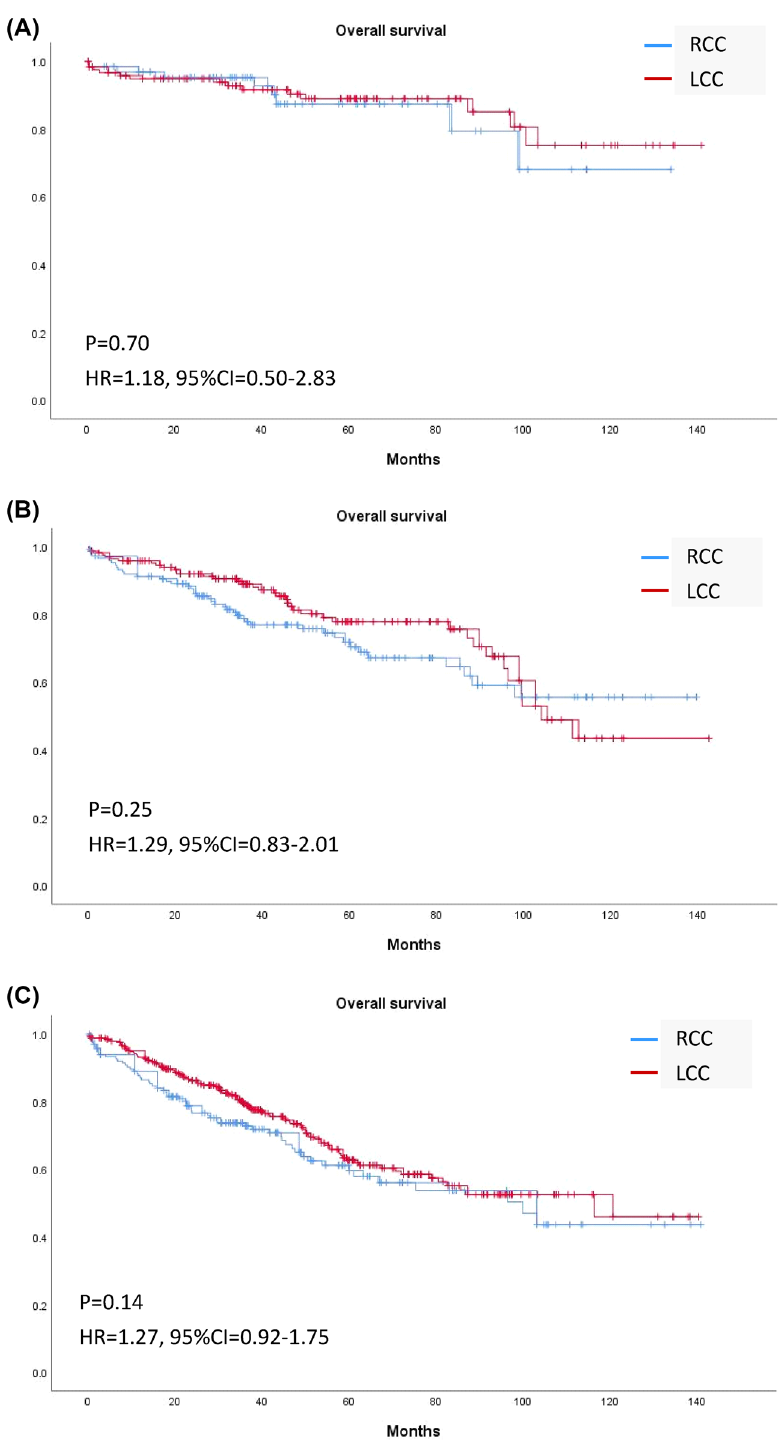
Figure 3. Kaplan–Meier curves of overall survival of right-sided and left-sided colon cancer in ( A ) Stage I, ( B ) Stage II, and ( C ) Stage